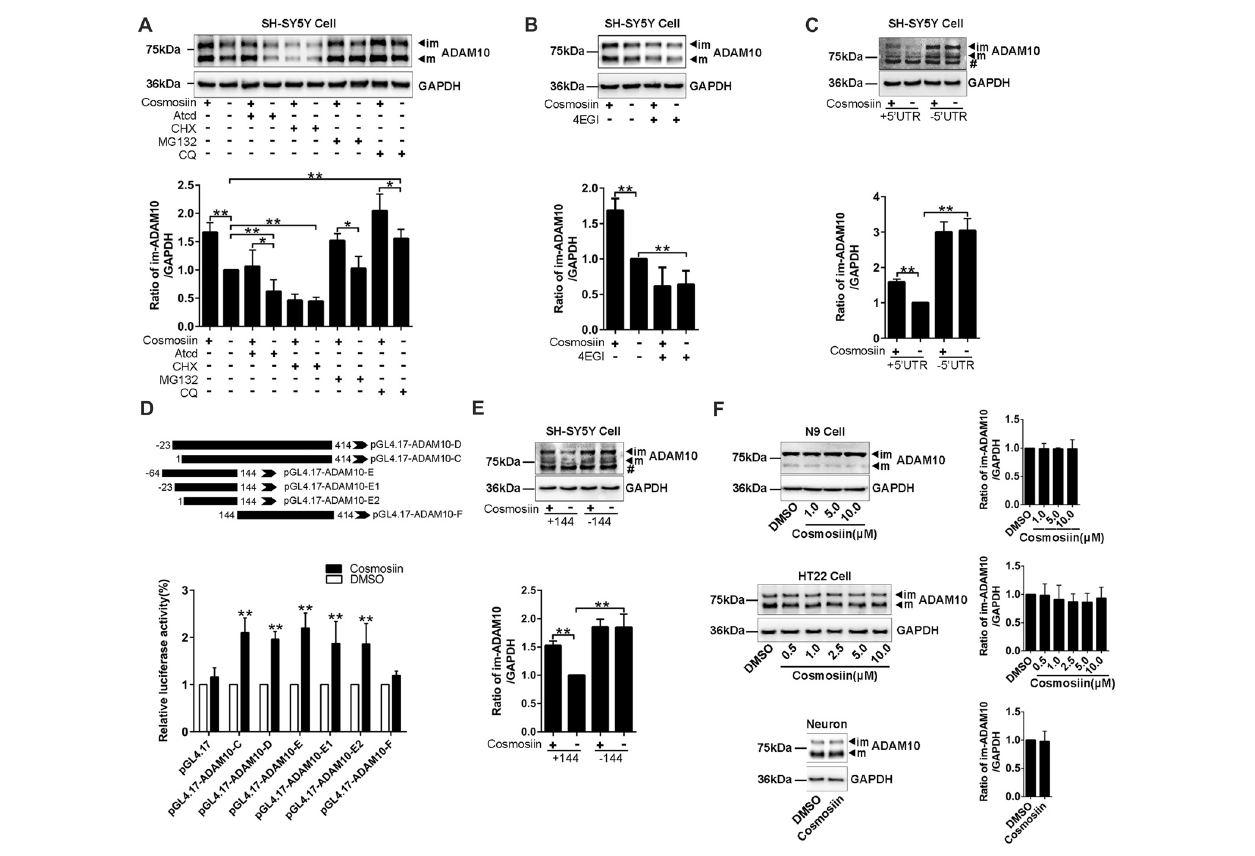
FIGURE 2 | Cosmosiin regulation of ADAM10 involves the first 144 nucleotides of 5’-untranslated region (5’UTR). (A) Representative Western blots (top) and bar plot summary (bottom) of ADAM10 levels in SH-SY5Y cells treated with cosmosiin (5 µ M, 36 h) or DMSO (1:10,000), in the absence or presence of transcription inhibitor actinomycin D (ActD, 0.1 µ M for 12 h), translation inhibitor cycloheximide (CHX, 5 µ M for 6 h), proteasome inhibitor MG132 (1 µ M for 6 h), or lysosome inhibitor chloroquine (CQ, 100 µ M for 6 h). (B) Representative Western blots (top) and bar plot summary (bottom) of ADAM10 levels in SH-SY5Y cells treated with